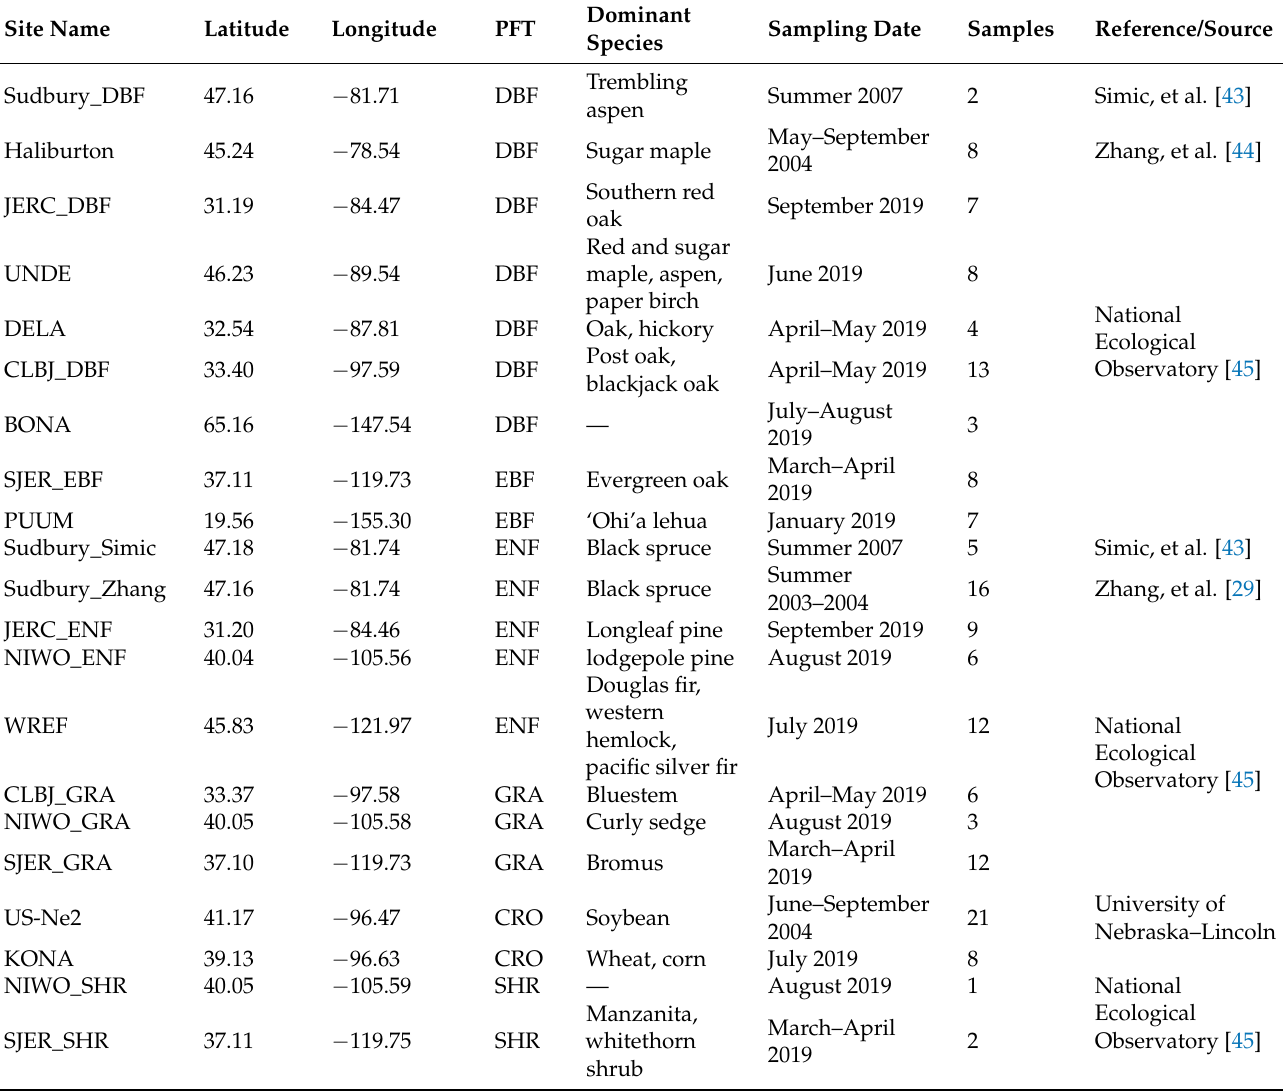
Table 2. Details of the field measurements of LCC for validation used in this study.